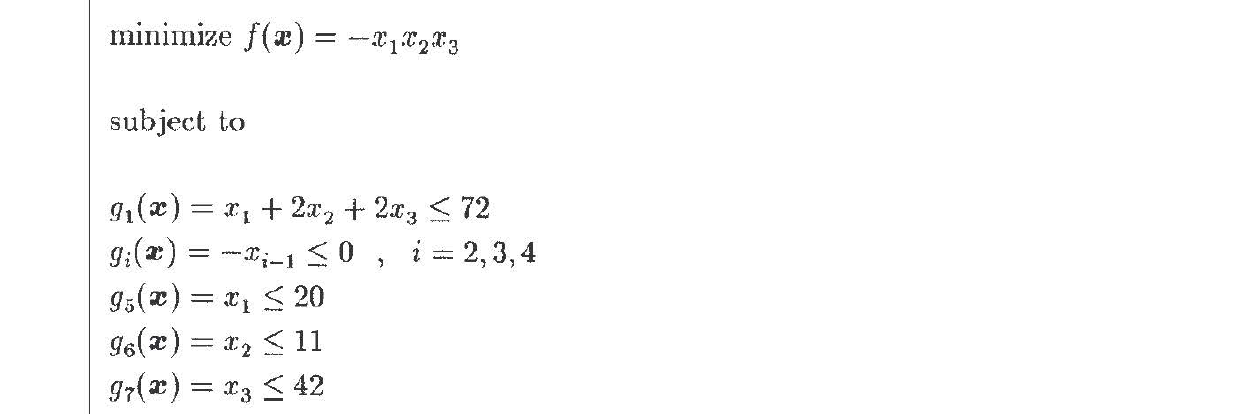
Figure 2: Progress of algorithm in Example 3